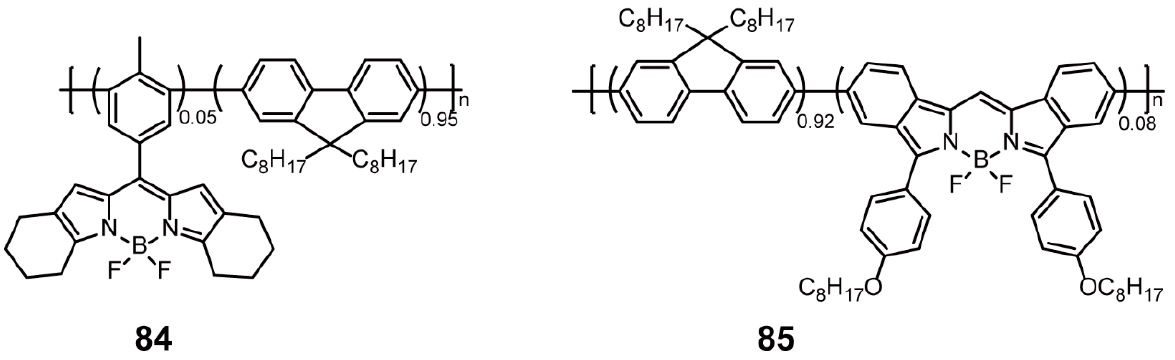
Figure 30. Chemical structures of polymers 84 and 85 (Reproduced with permission from Reference [108]. Copyright @ 2016, Royal Society of Chemistry). Table 1. Summary of the structures and synthetic methods of BODIPY-based conjugated polymers. Structures of BODIPY-Based Conjugated Polymers